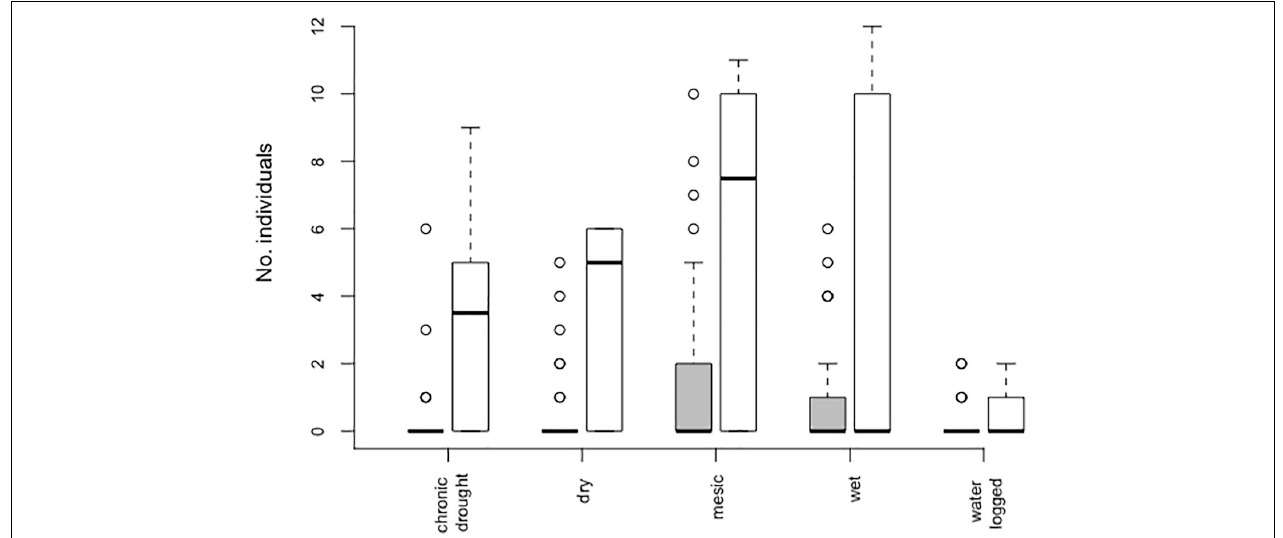
FIGURE 2 | Number of Bunias orientalis individuals established per pot (from initially 12 sown seeds) over 3 years (2016–2018) depending on water table depth treatment in the community (gray bars, n = 40 each) and empty pots (white bars, n = 10 each). Boxplots show the median per group (solid line), boxes represent the 25th and 75th quantile, whiskers the normal data range and circles the outliers.